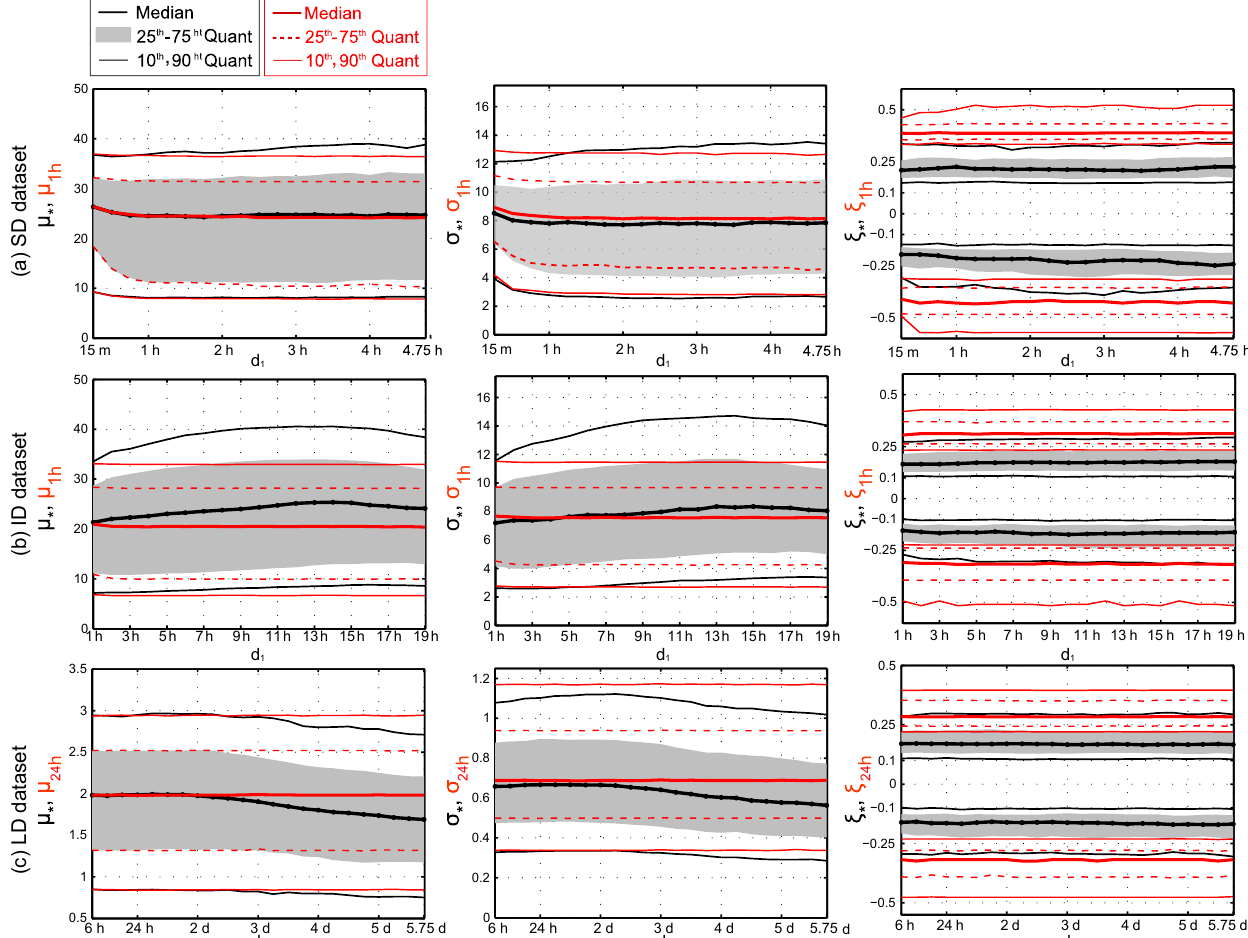
Figure 9. Distribution over valid SS stations of SS GEV parameters (grey and black lines) for 6-duration scaling intervals and non-SS GEV parameters (red solid and dashed lines) for reference durations. Location and scale parameters (first and second column, respectively) are scaled at d ∗ = 1h (SD and ID datasets) and d ∗ = 24h (LD dataset). Distributions for the shape parameter (third column) are presented for ξ > 0 and ξ < 0, excluding cases where ξ = 0 (Gumbel